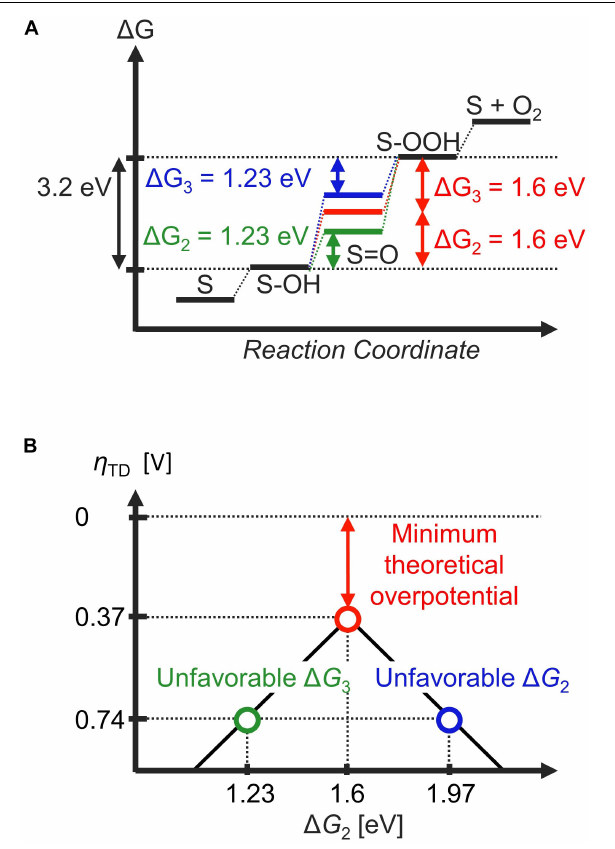
FIGURE 3 | The effect of the scaling relation on the thermodynamic free-energy landscape for the oxygen evolution reaction (OER), assuming the participation of OH, O, and OOH adsorbates within the catalytic cycle. (A) Due to the linear scaling relationship between the OH and OOH adsorbates ( (cid:49) G 2 + (cid:49) G 3 = 3.2 eV), it is not possible to adjust both (cid:49) G 2 and (cid:49) G 3 to 1.23 eV simultaneously (blue and green pathways). The minimum thermodynamic (theoretical) overpotential is realized when (cid:49) G 2 = (cid:49) G 3 = 1.6 eV; that is, the free-energy penalty due to the scaling relations is shared equally between these two elementary steps. (B) The thermodynamic overpotential is plotted as a function of (cid:49) G 2 in the form of a volcano